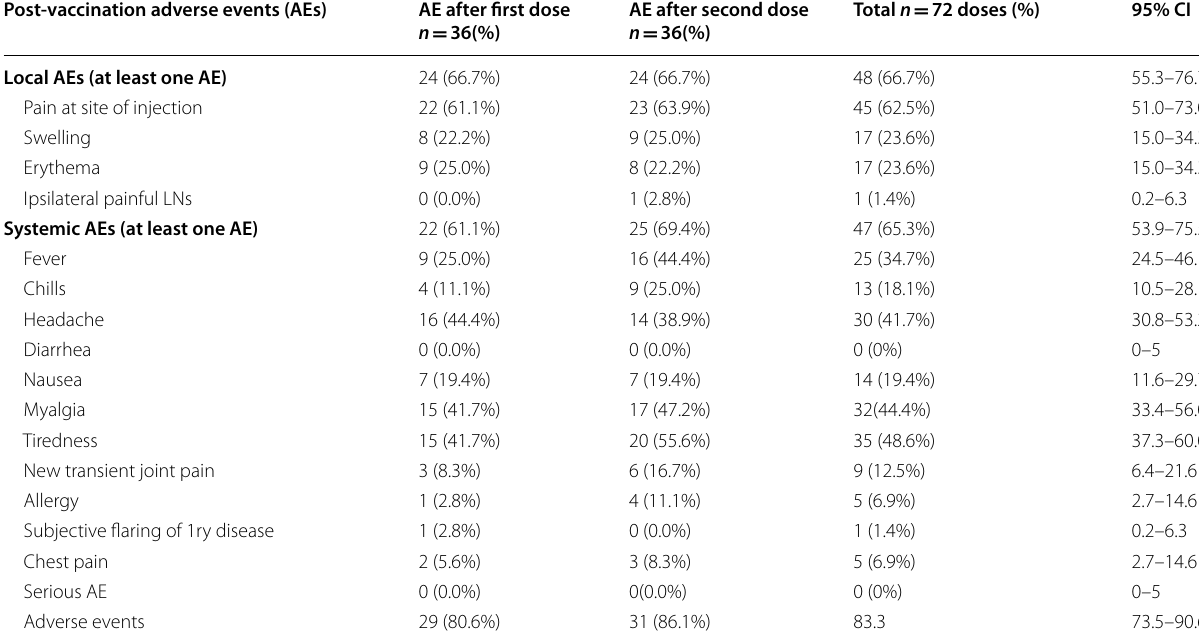
Abbreviations: AE Adverse event, LN Lymphadenopathy